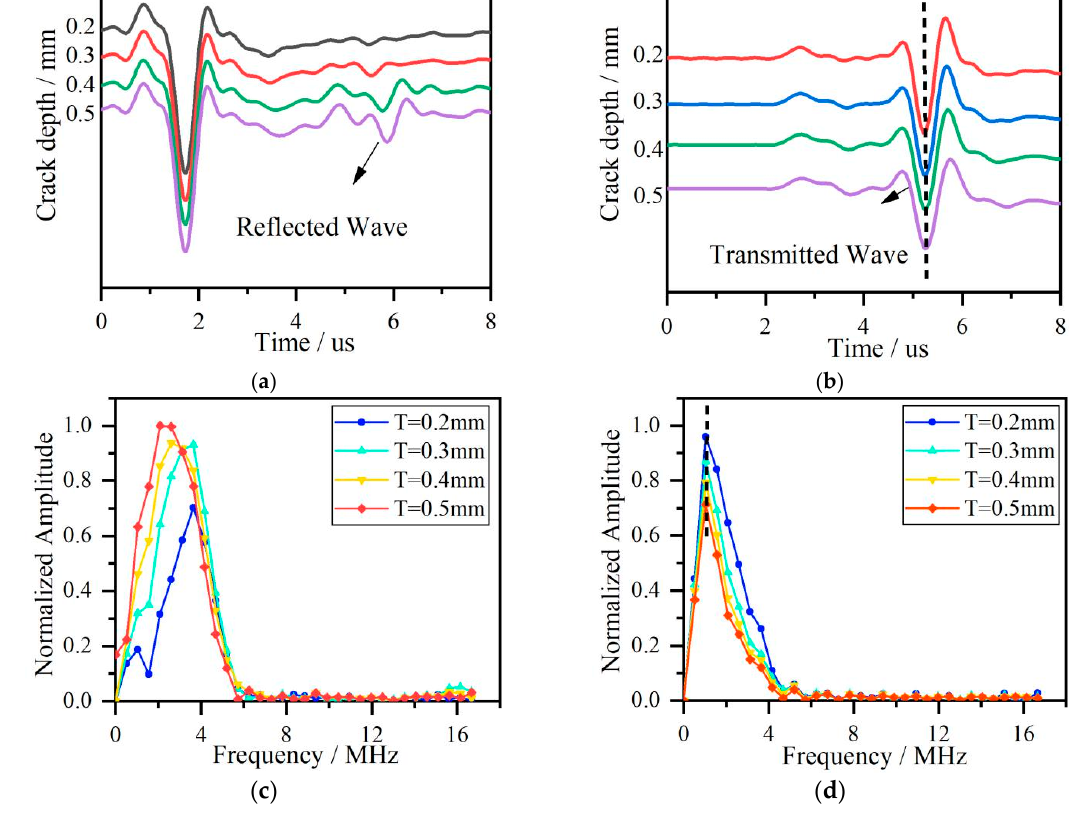
Figure 6. ( a ) Reflected Rayleigh waves. ( b ) Transmitted Rayleigh waves. ( c ) The frequency spectra of the reflected Rayleigh waves. ( d ) The frequency spectra of the transmitted Rayleigh waves. The acoustic waves are obtained at cracks with depth as 0.2 mm, 0.3 mm, 0.4 mm, and 0.5 mm.